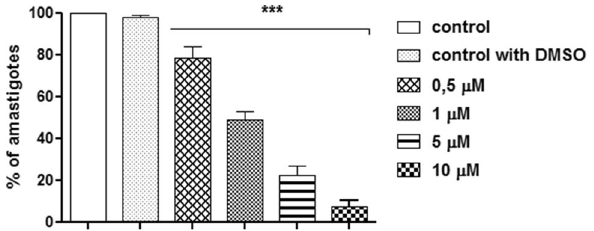
Figure 2. T. cruzi amastigotes proliferation in the presence of FEX. The number of parasites was reduced in a dose-dependent way. The number of parasites reduced from 20% after treatment with 0.5 µM to 93% with 10 µM. The data are the average of three independent experiments in triplicate (***p < 0.001).